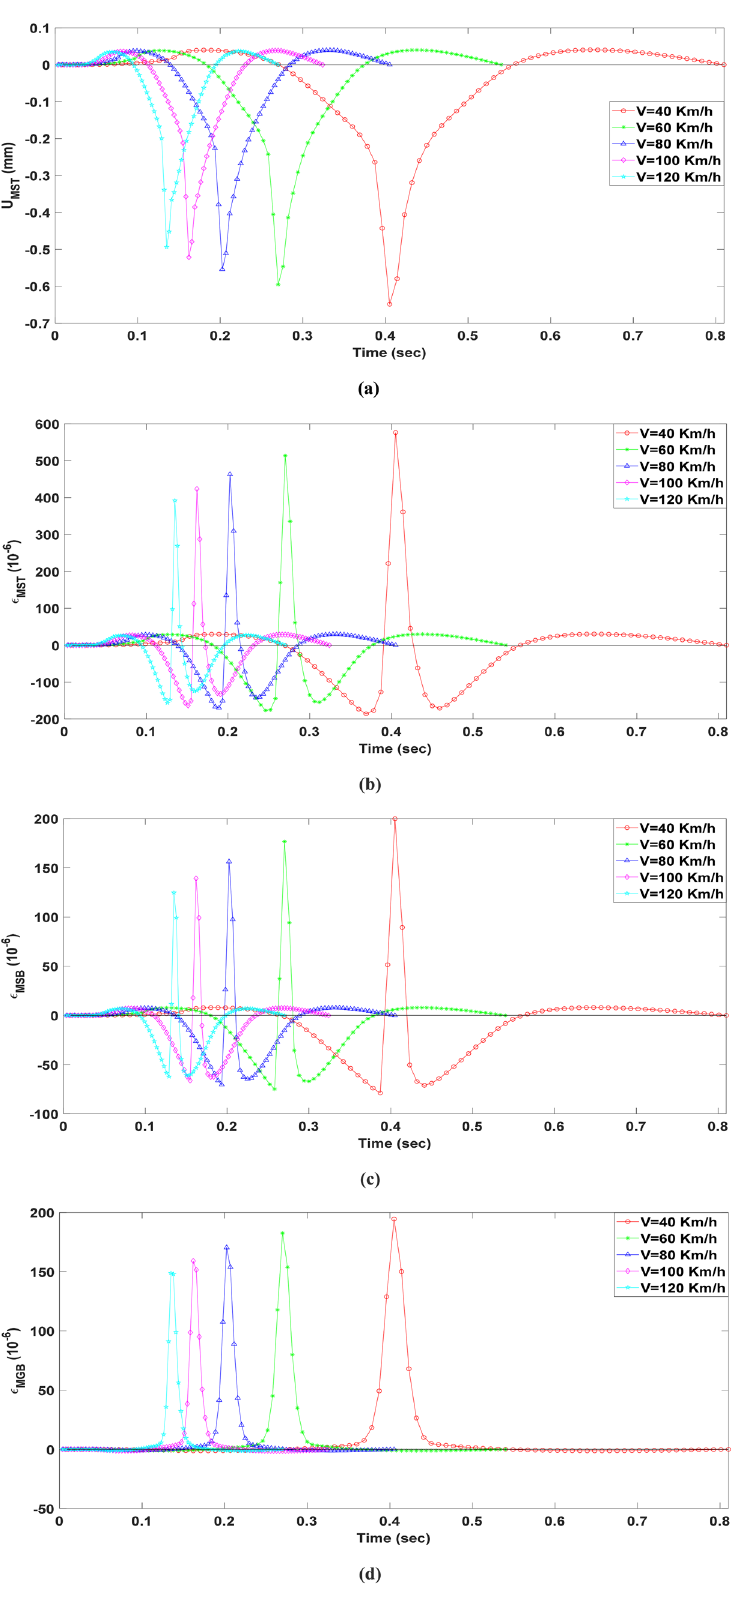
Figure 12. Critical responses of deck pavement under moving